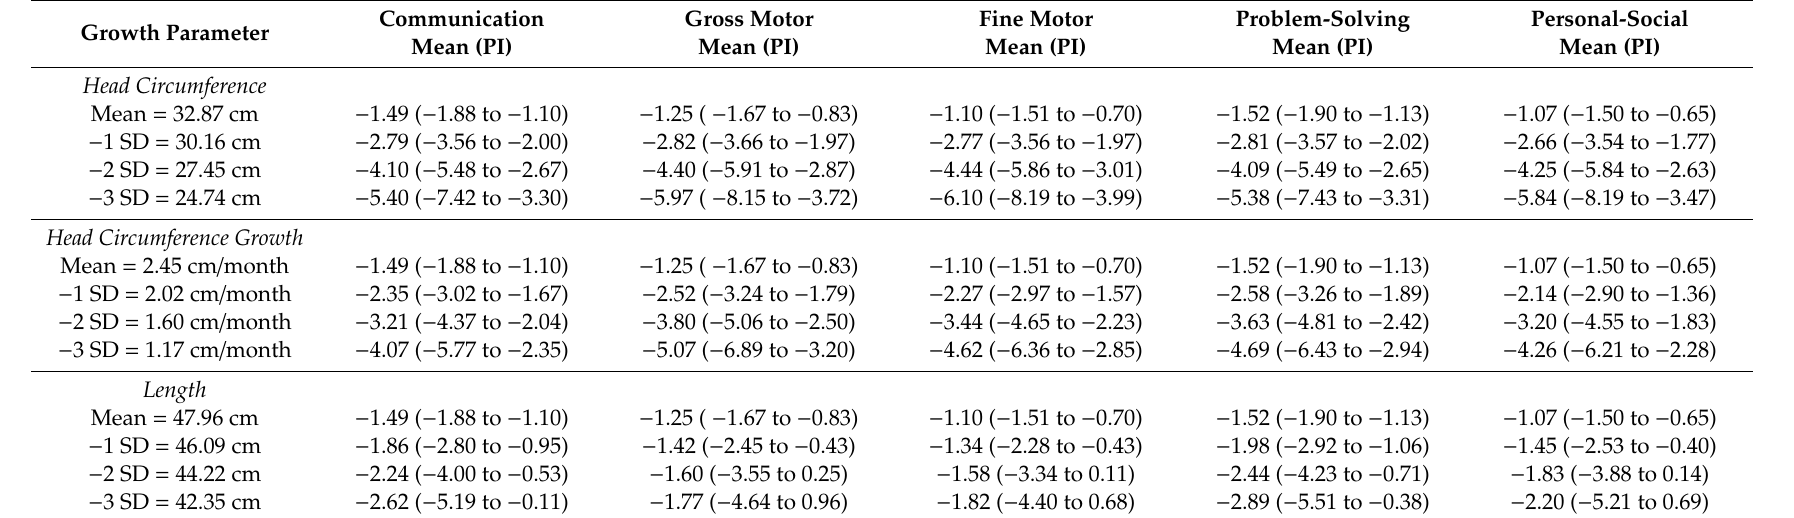
Table 3. The estimated impact on developmental delay by ASQ-3 domain using the Bayesian head circumference (HC), length, and developmental delay